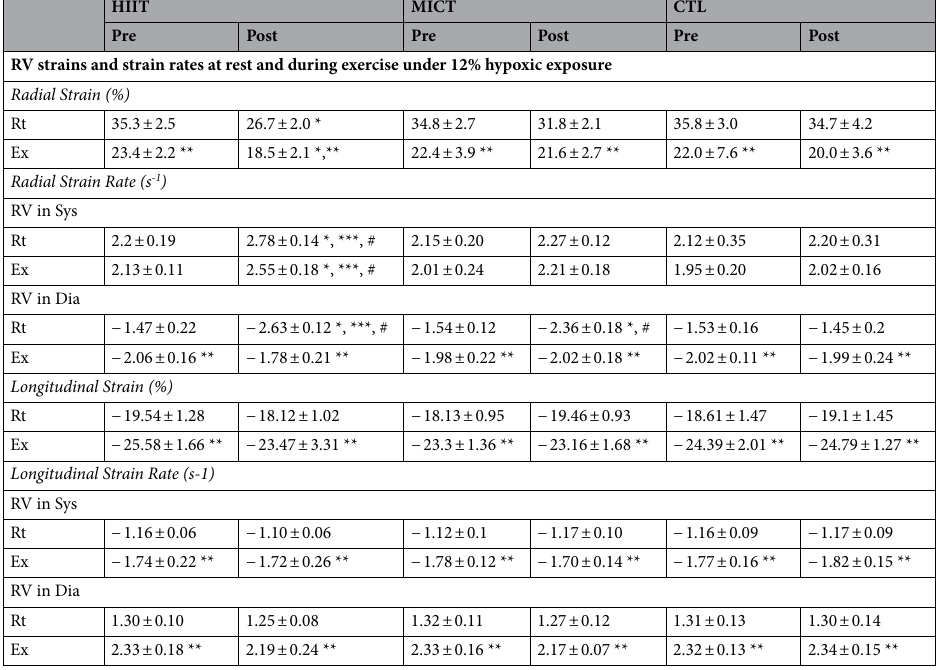
Table 4. The effects of interval and continuous exercise regimens on RV mechanics in HE. Values were mean ± SEM. Values were mean ± SEM. RV in Sys: when RV in systolic phase; RV in Dia: when RV in diastolic phase. *P < 0.05, Pre- vs Post- ; **P < 0.05, Rt vs Ex; ***P < 0.05, HIIT vs MICT; #p < 0.05, HIIT or MICT vs CTL.